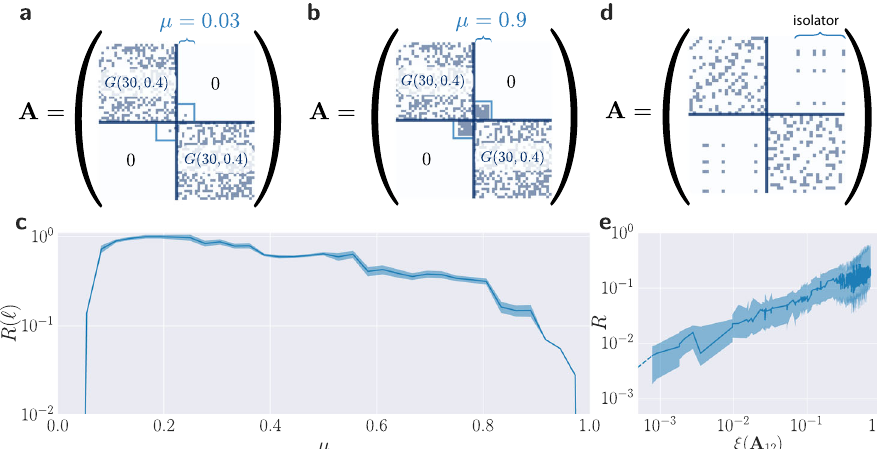
Fig. 2 Effectiveness and robustness of shielding network structures. a , b Adjacency matrices for the graphs shown in Fig. 1a, b. Two random graphs G (30,0.4) are inter-connected via a fraction c = 0.2 of their nodes chosen at random, and links are added with probability μ , interpolating between weak ( a ) or strong ( b ) interconnectivity (see Methods for details). c The average ratio of fl ow changes R ( ℓ ) in the two components (Eq. (8)) is strongly suppressed for both high and low interconnectivity μ . The blue line represents the median value over all distances and the shaded region indicates the 0.25- and 0.75-quantiles. d Adjacency matrix for the six-regular graph shown in Fig. 1c and containing a network isolator. Note that all nodes in the graph including those in the network isolator have degree equal to six, which allows us to exclude any potential impact of heterogeneity in the degree on failure spreading in this case. e The ratio of fl ow changes R , now averaged over all possible trigger links ℓ and distances d , vanishes for a network isolator described by the condition ξ ( A 12 ) = 0 and increases algebraically with the coherence parameter ξ (cf. Eq. (10)) when perturbed (see Methods for details on the simulation). Again, median and 0.25- and 0.75-quantiles are shown resulting from averaging over all distances and then trigger